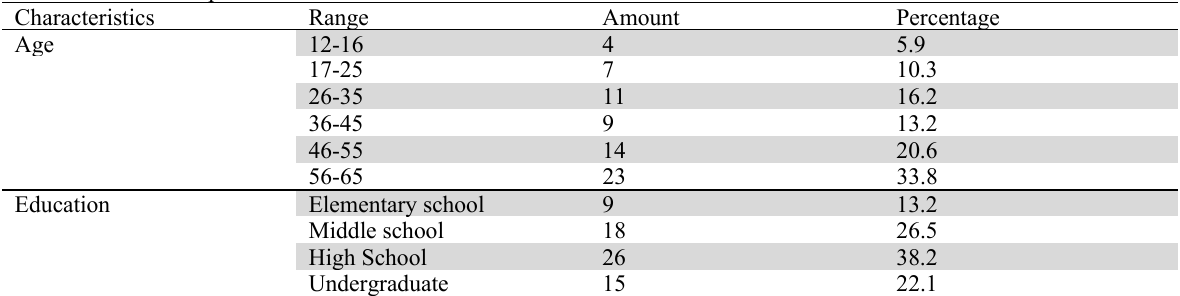
Characteristics of Respondents Characteristics Range Amount